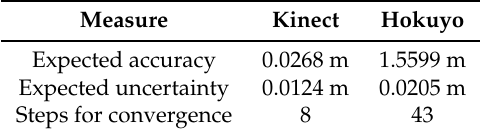
Table 5. Steady-state measures of filtering performance for the sensors used in the real experiment. The expected accuracy and uncertainty were calculated taking into account the last 4 steps of the